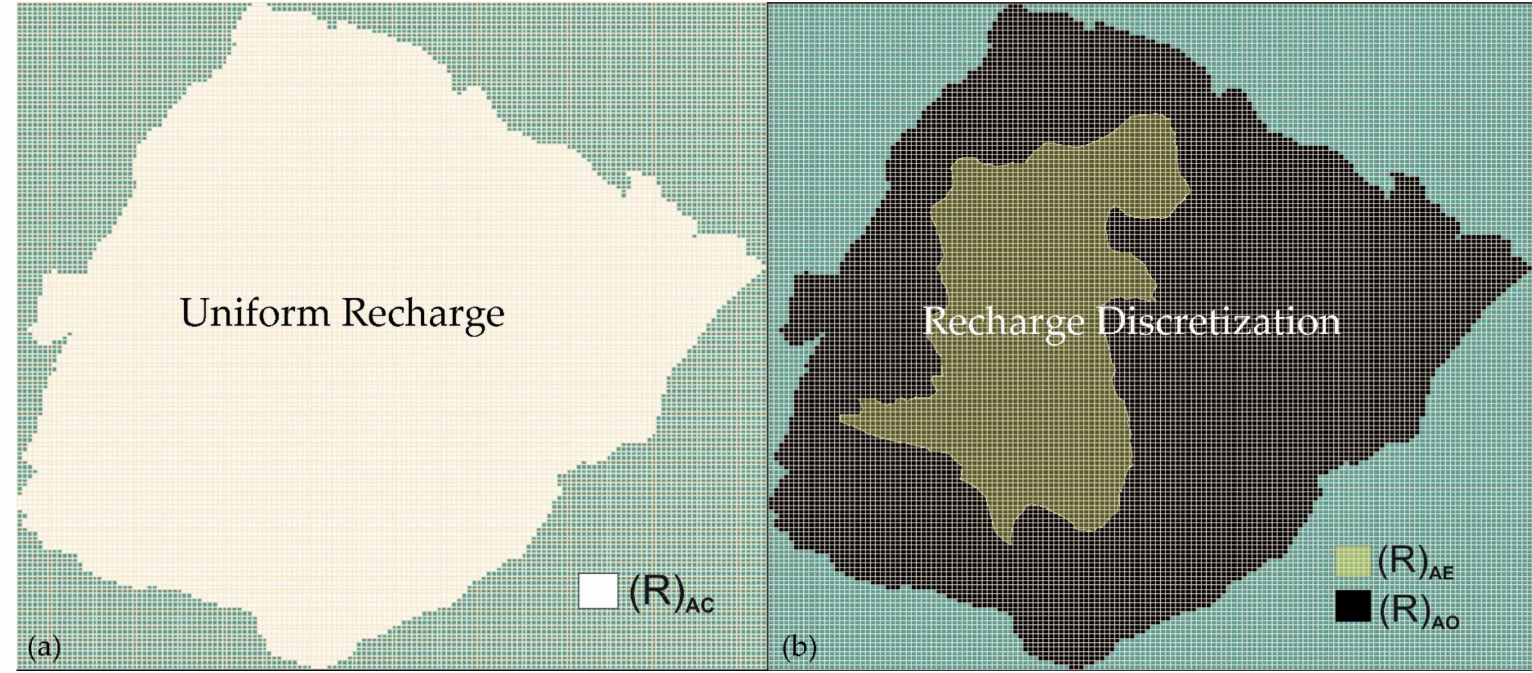
Figure 7. ( a ) The recharge amount uniformly assigned to the Caposele catchment area (R) AC and ( b ) discretized according to the endorheic (R) AE and open areas (R) AO of the model domain. VISUAL MODFLOW FLEX 2015.1 is the graphic user interface used to drawn the